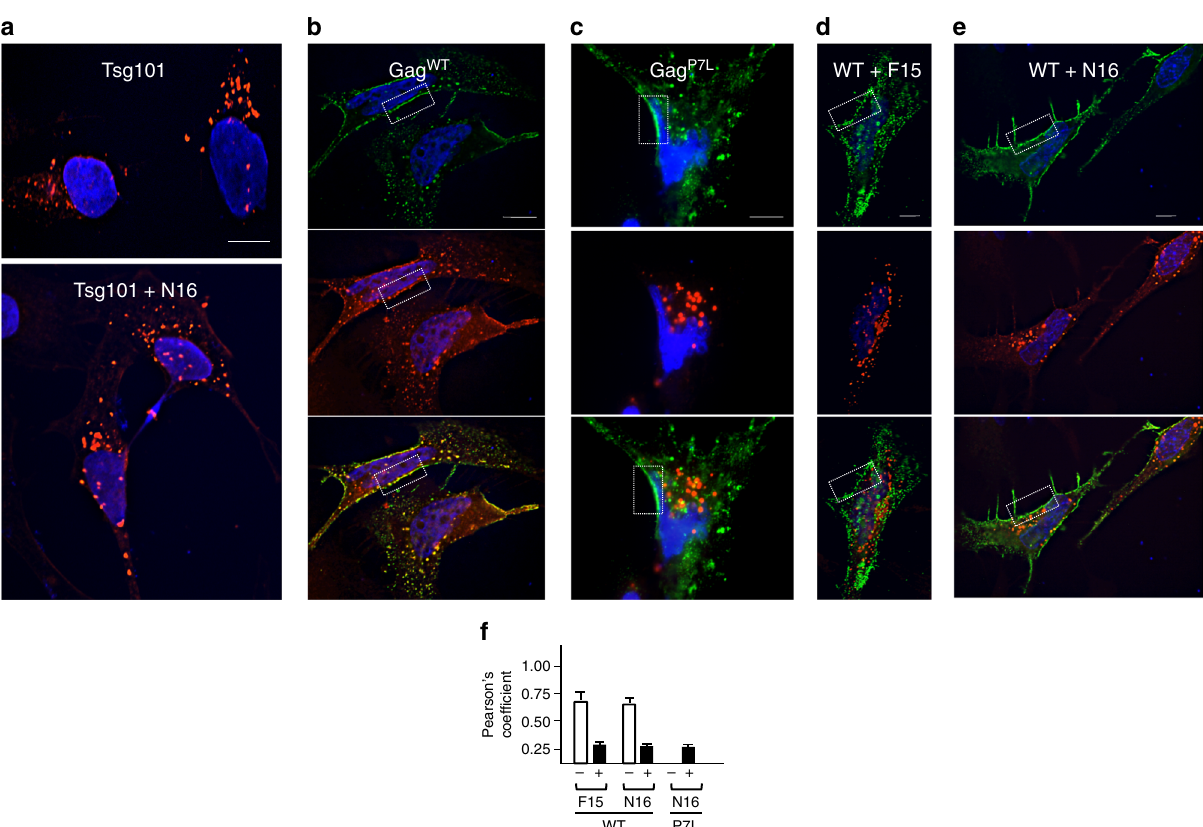
Fig. 2 N16 (50 µ M) prevents co-localization of Gag and Tsg101 on the plasma membrane. a – e Fluorescence microscopy images of cells that co-express Tsg101-Myc alone or Gag WT -GFP and Tsg101-Myc. Cells grown on coverslips were co-transfected with DNA encoding Tsg101-Myc a or Tsg101-Myc and Gag WT -GFP b , d , e or Gag P7L -GFP c and treated with F15 d or N16 e . After 24 h the coverslips were processed for microscopy with Tsg101-Myc detected with anti-Myc antibody and Texas Red secondary antibody as described in Methods section. Scale bars = 10 microns. a Tsg101-Myc in cells treated with DMSO carrier (top) or N16 (bottom). b – e Top panels, show signal from Gag-GFP (green); middle panels, images showing Tsg101-Myc signal; bottom panels, merged images showing signals from Gag-GFP and Tsg101-Myc. Boxes frame a region of the plasma membrane. f Pearson ’ s coef fi cient of correlation values determined for the images shown. Error bars indicate the highest values obtained for similar samples. n =